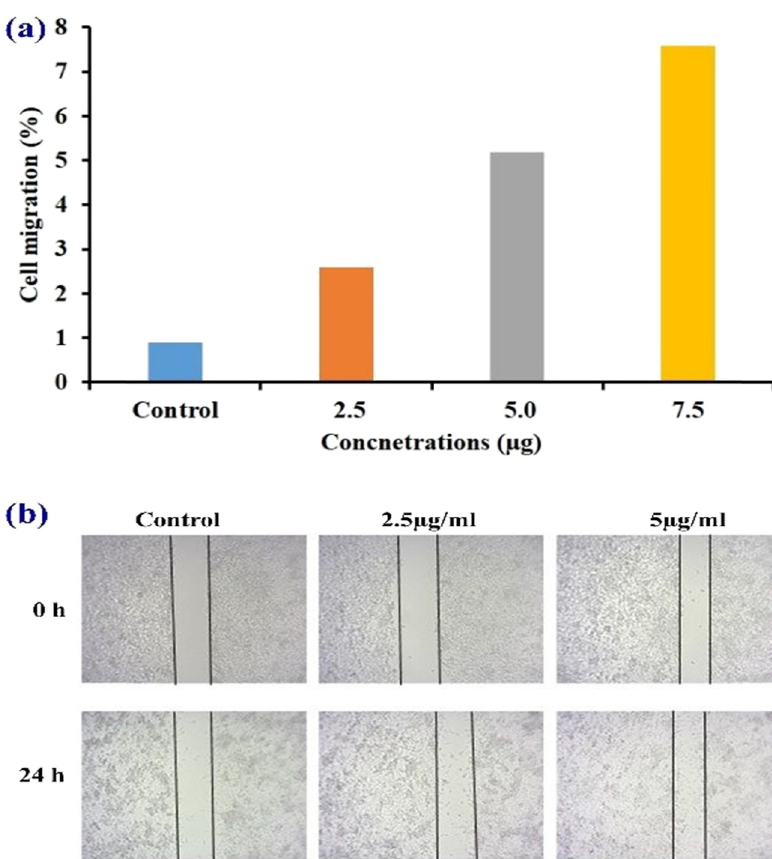
Figure 7: ( a ) In vitro cell migration vs fabric coated phyto - mediated metal nanoparticles synthesis ( wound healing ) . It reveals the minimal concentration ( 2.5 µg · mL − 1 ) of mixed cotton - coated A. sessilis mediated zinc oxide nanoparticles show an elevated cell migration in wound scratch assay. ( b ) E ff ect of AS - ZnONPs on cell migration of L929 cells. Cell migration assay 2.5 and 5 µg · mL − 1 of AS - ZnONps treated against human fi broblast cells for 24 h no changes were observed compared with control which proves it is non -